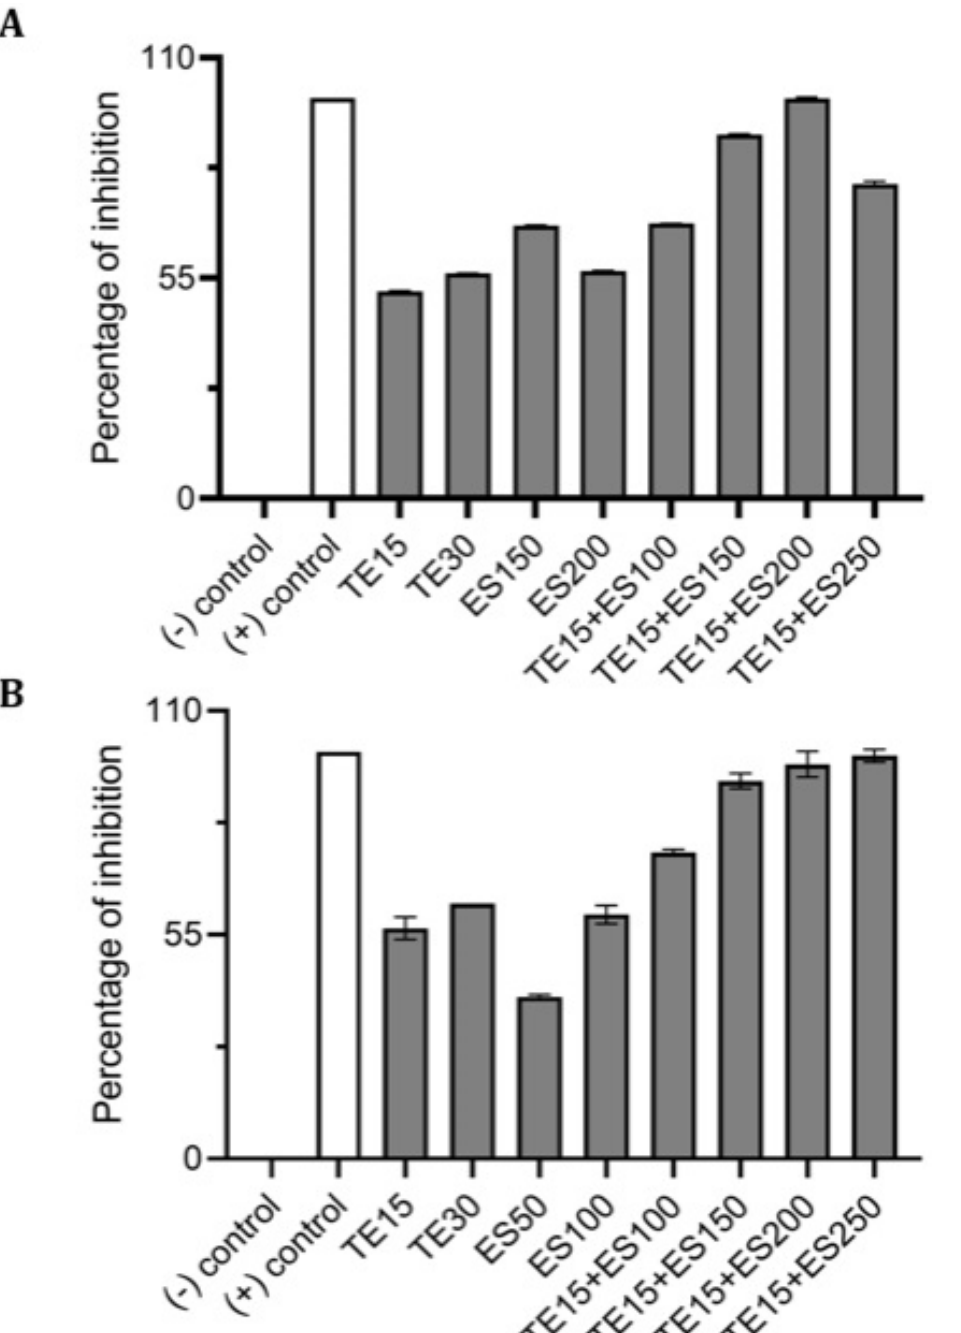
Figure 7. Effect of single and combinatorial treatments of tetracycline (TE) and EGCG-S (ES) on biofilm formation in S. aureus . The percentage of inhibition for ( A ) crystal violet assay and ( B ) Resazurin assay were calculated from respective measurement. (-) control: PBS buffer; (+) control: 10% bleach. Experiments were repeated in triplicates. Means are shown with SD. The percentage of inhibition with different concentrations of tetracycline and EGCG-S indicated that TE10+ES200 inhibits biofilm formation of S. aureus most effectively.